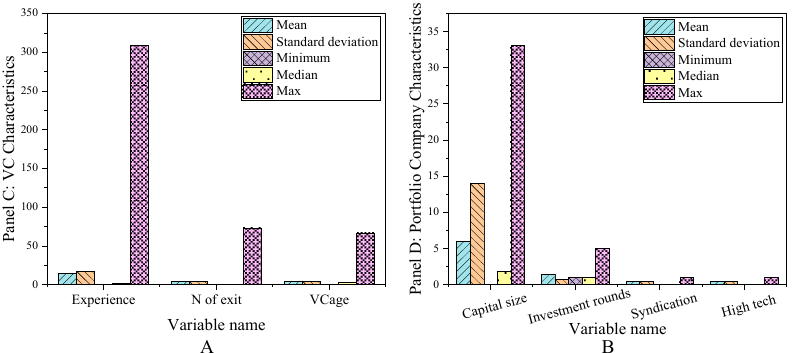
Figure 3. Descriptive statistical results of main variables in sample interval ( A ) Panel C; ( B ) Panel D.